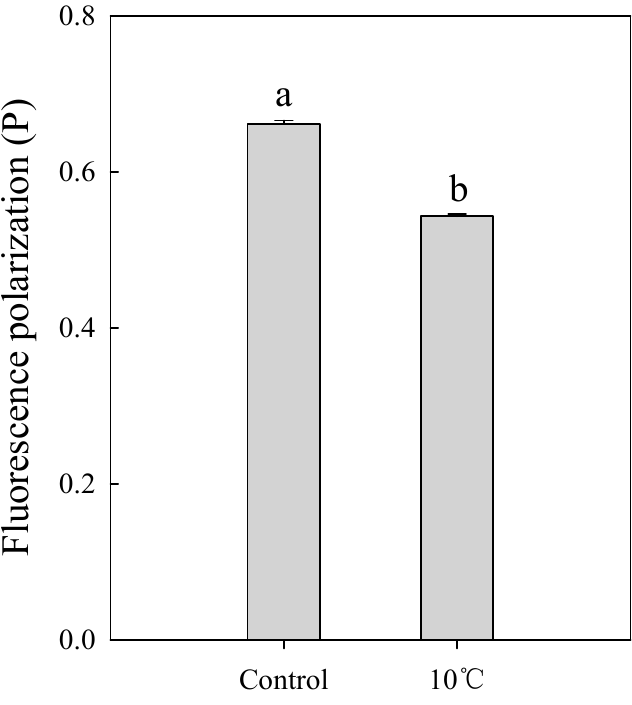
Figure 4. Cold adaption enhances cation influx into the bacterial cells by enhancing cation channel activity in the bacterial cells. Fluorescence polarization of L. brevis WiKim0069 in the presence or absence of cold adaptation.